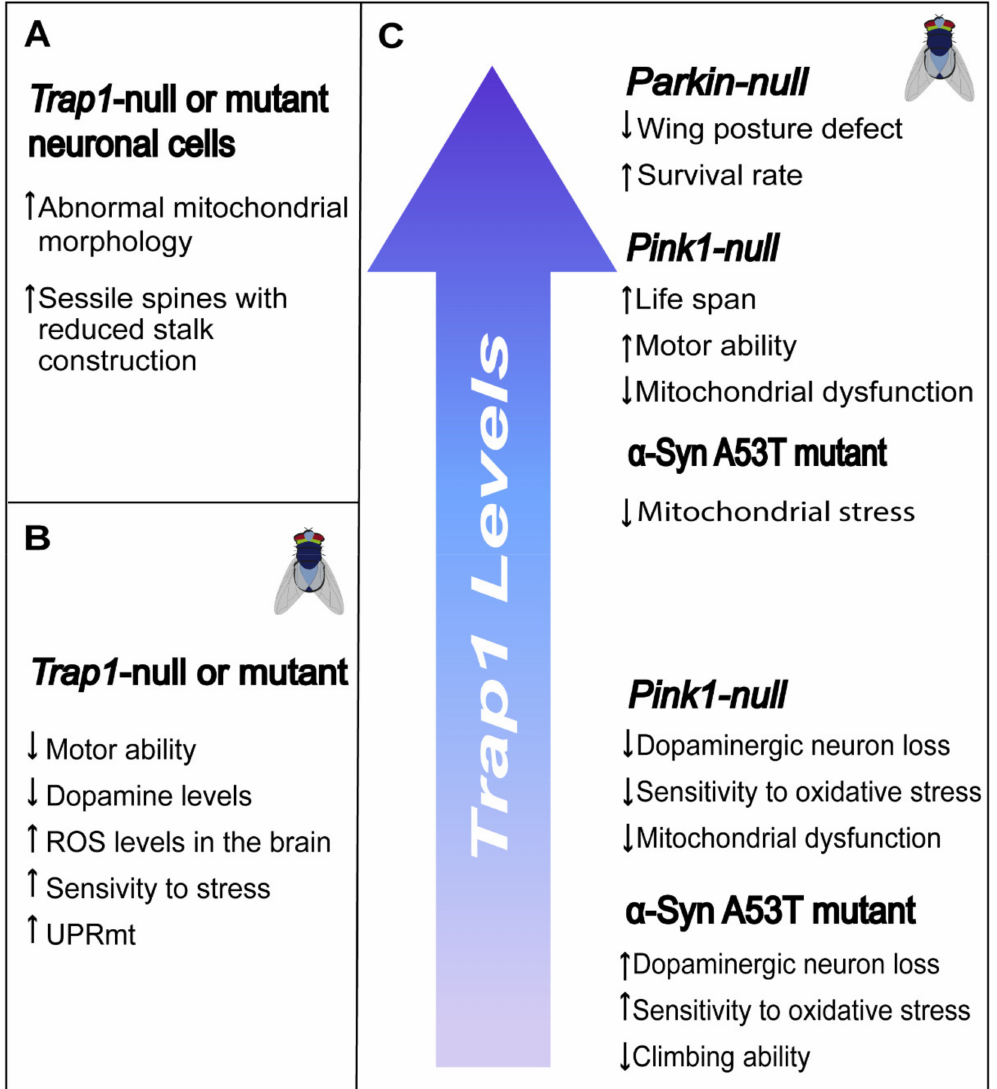
Figure 5. Role of TRAP1 in neurodegeneration. ( A ) SH-SY5Yneuroblastoma cells lacking TRAP1 showed abnormal mitochondrial morphology, with decreased number of fragmented mitochondria with increased connectivity. Moreover, hippocampal rat neurons with reduced levels of TRAP1 presented an increased number of sessile spines with reduced stalk construction. ( B ) Trap1 -null or mutant flies presented decreased motor ability and dopamine levels, while showing increased reactive oxygen species (ROS) levels in their brains, increased sensitivity to stress, and increased mitochondrial unfolded protein response (UPRmt). ( C ) Knockdown or overexpression of TRAP1 in different genetic backgrounds has different outcomes in terms of survival of dopaminergic neurons, mitochondrial dysfunction, life span, and motor